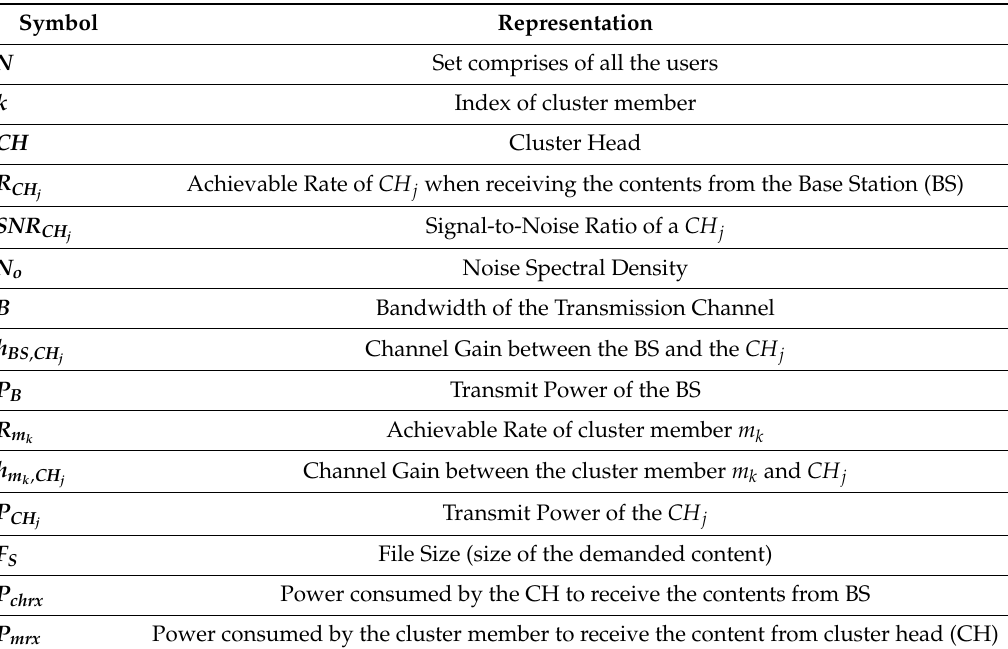
Table 2. List of